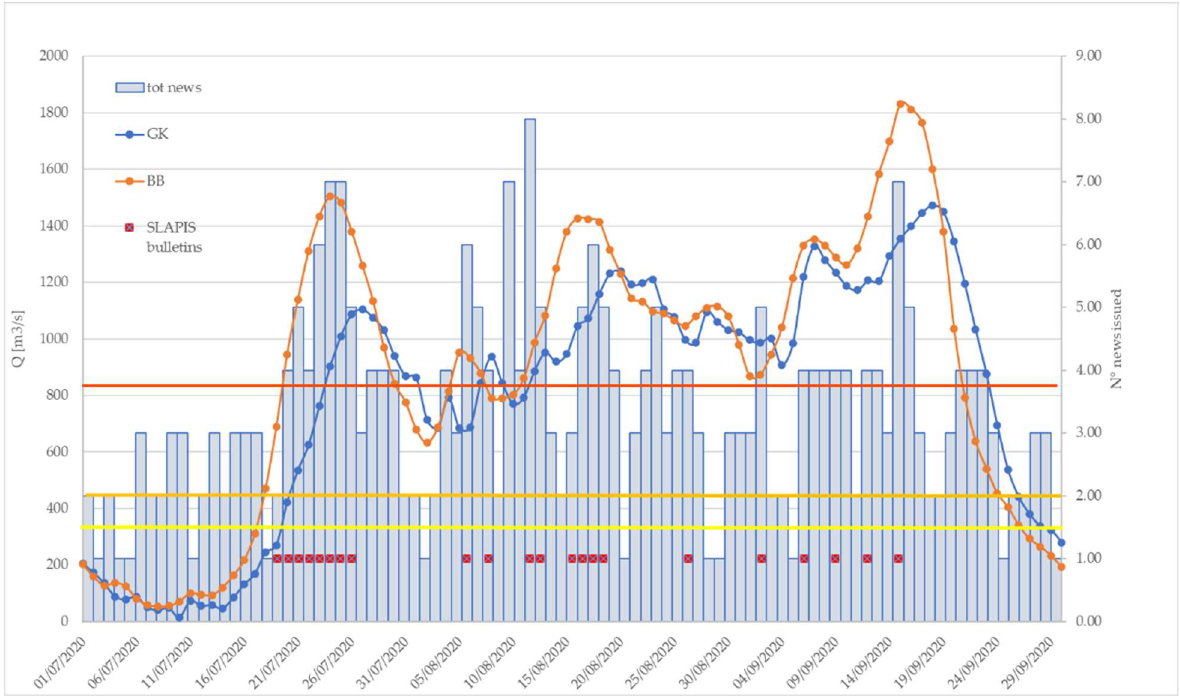
Figure 10. Hydrograms of the Sirba at Garbey Kourou (GK) and Bossey Bangou (BB) and information produced during the 2020 hydrological season. Table 8. Information produced by SLAPIS during the 2020 hydrological season by type of information. Type